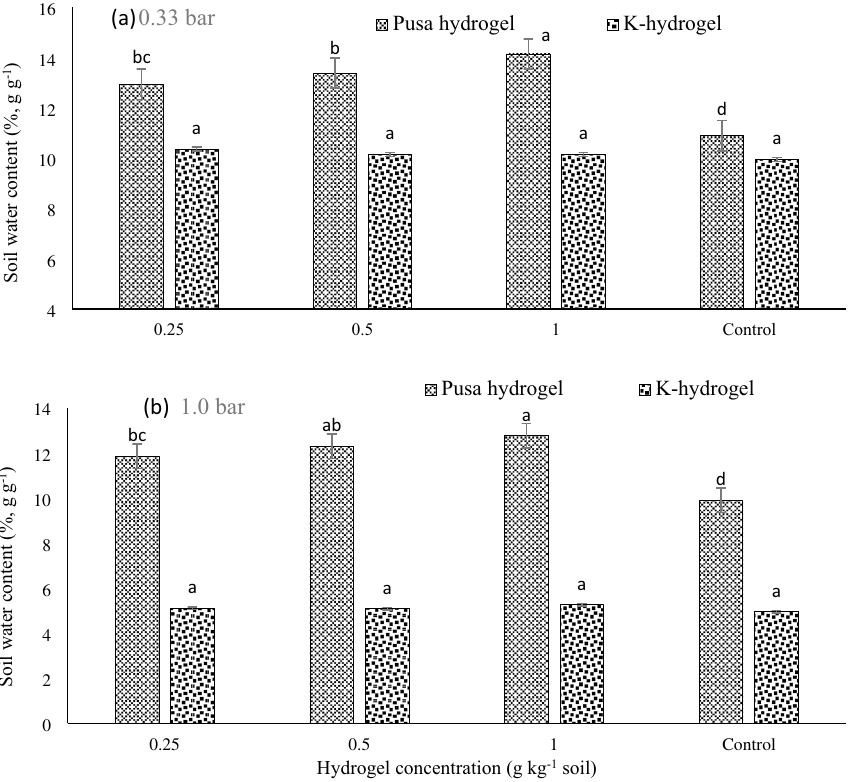
Figure 6. Pressure plate apparatus determined soil moisture retention release [( a ) 0.33 bar and ( b ) 1.0 bar] under P- and K-hydrogels under different hydrogel concentreations. Bars indicate standard error of